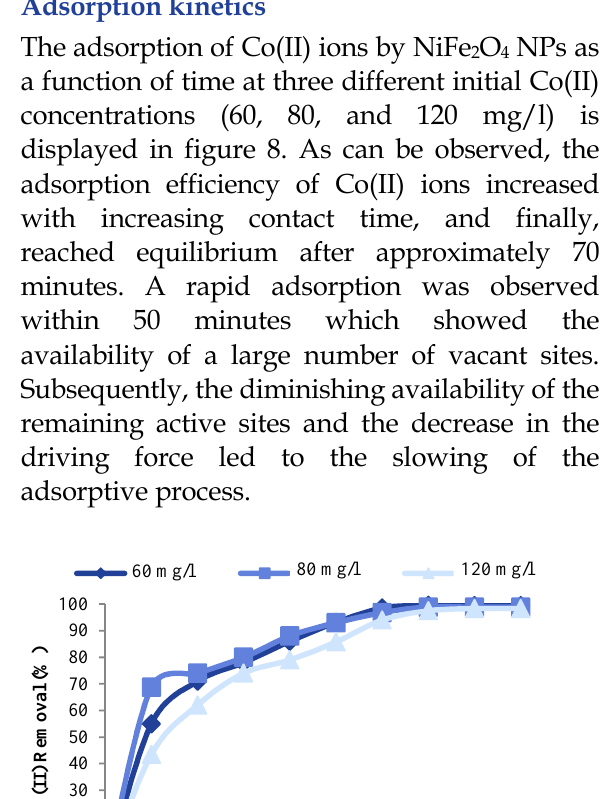
O nanoparticles 2 4